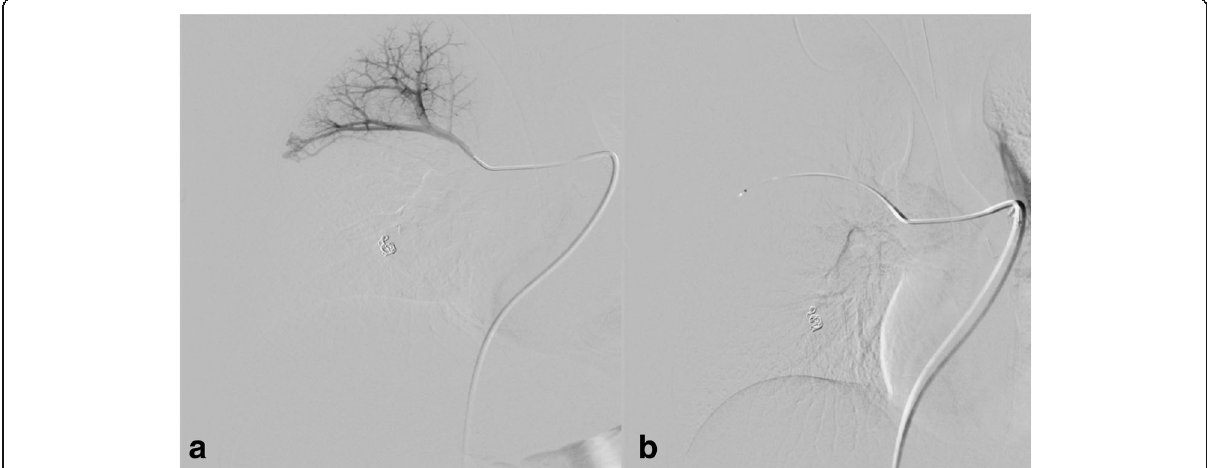
Fig. 3 a A 19-year-old woman with HHT. Small PAVM with feeding artery 3.2 mm in the right upper lobe. b Previous embolization with coils of complex PAVM in the same lobe